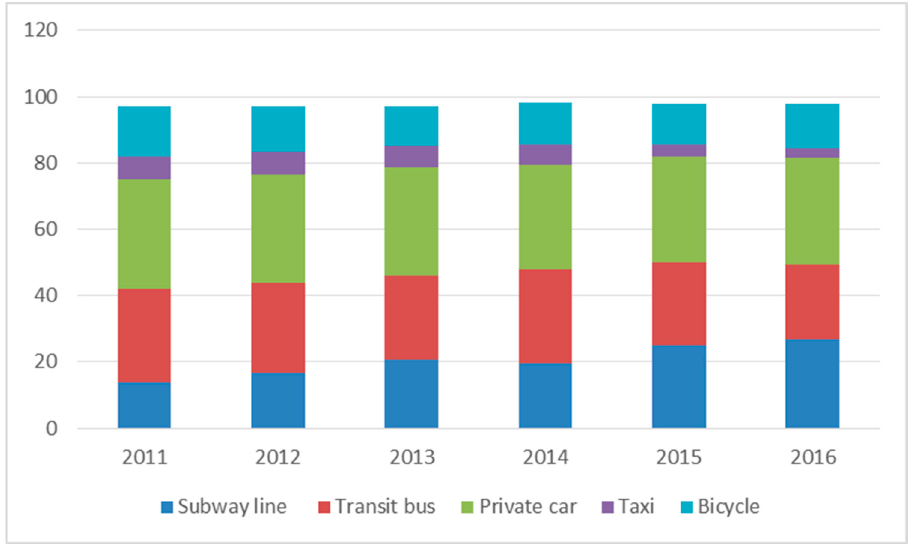
Figure 2. Traffic mode split distribution in Beijing from 2011 to 2016. Figure 2. Tra ffi c mode split distribution in Beijing from 2011 to